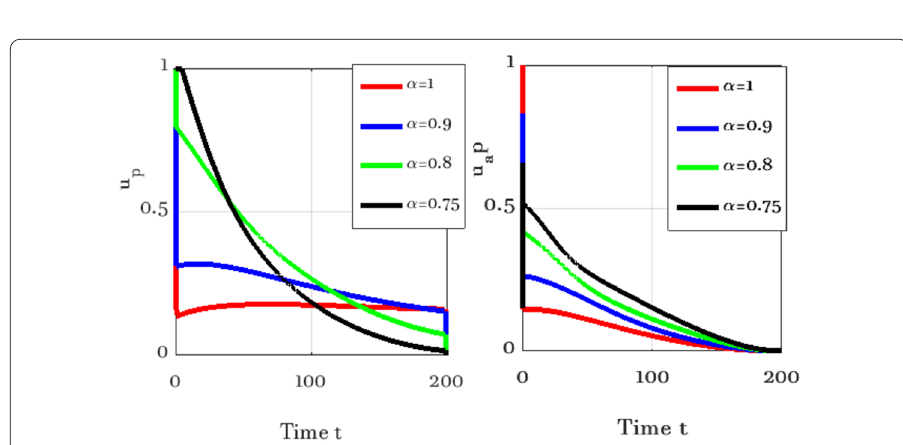
Figure 3 Numerical simulations of u p , u ap at different α , (cid:21) =